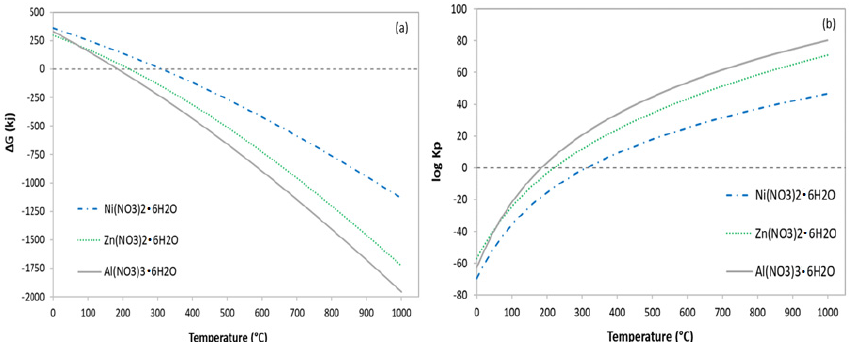
Figure 2. Thermodynamic investigation of the decomposition reactions for Ni, Zn and Al -nitrate salts to oxide forms; changes of ( a ) Gibbs free energy and ( b ) reaction equilibrium constant as a function of temperature.